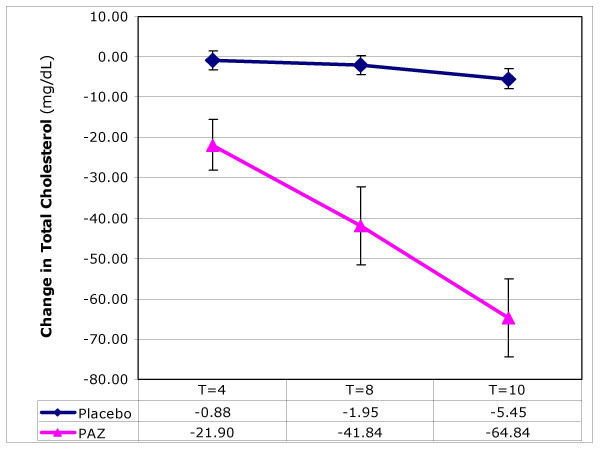
The effect of ProAlgaZyme vs. placebo on total cholesterol (mg/dL). Values are mean change at 4, 8 and 10 weeks compared to baseline within 95% confidence limits (+/- 1.96*(standard error of the mean)).